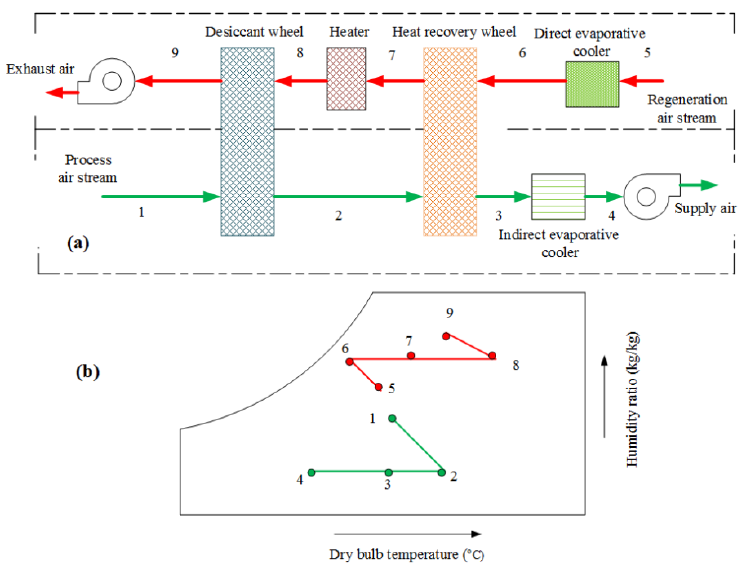
Figure 5. ( a ) Systematic of cooling system ( b ) psychometric processes.